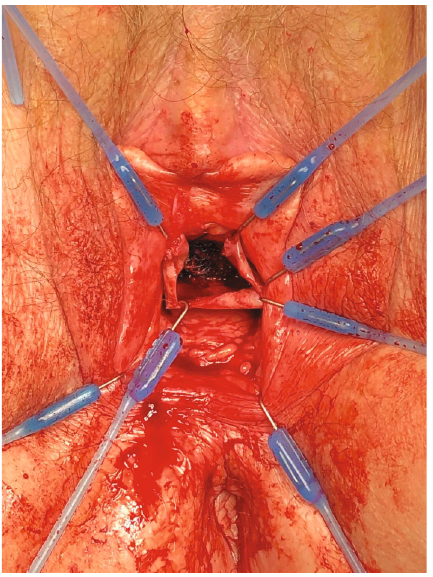
Figure 2: Use of transvaginal mesh to repair the hernia.